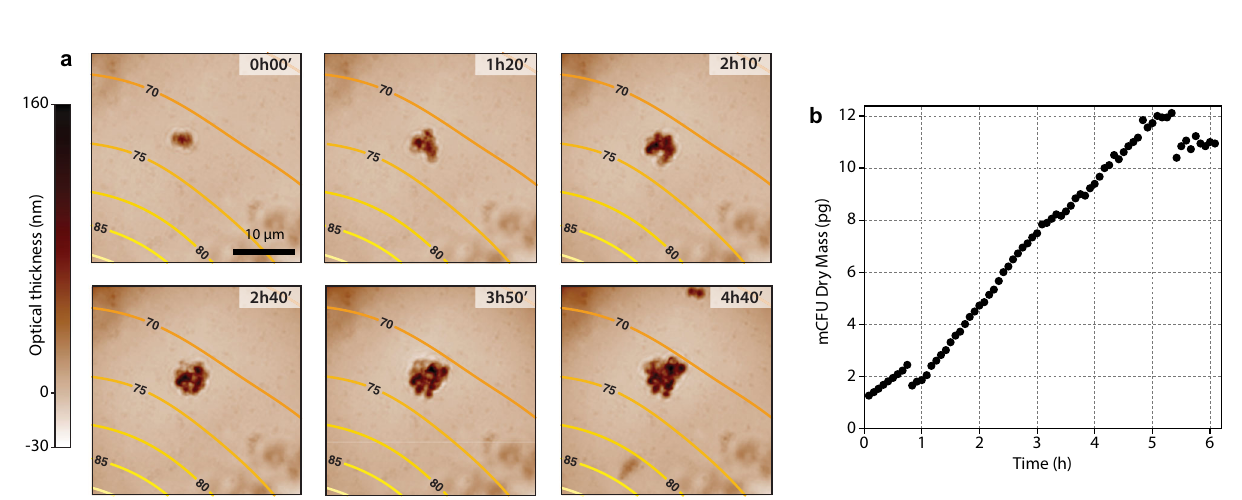
Fig. 6 | Germination of G. stearothermophilus followed by CGM, and activated by laser-heating. a Time lapse composedof 8OTimages(immersion oil, 60x, 1.25 NA objective lens), along with ( b ) the evolution of the biomass of the G.